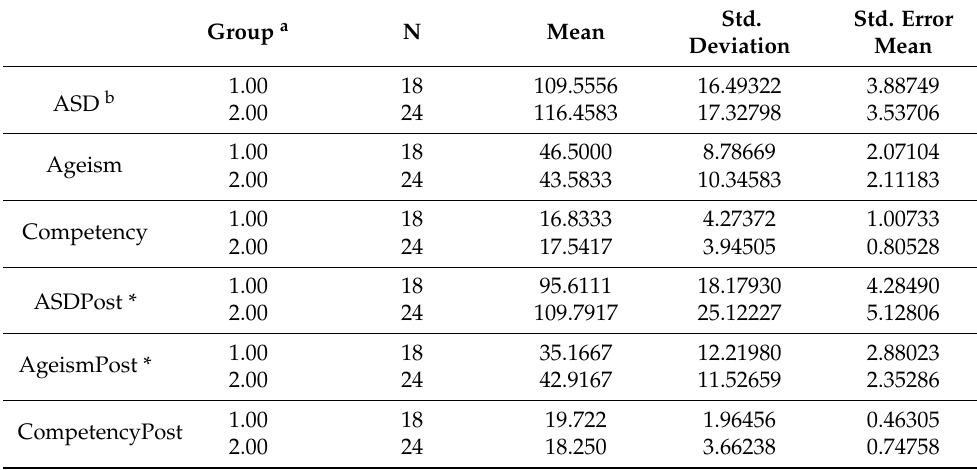
Table 1. Pre-Post Student Assessment Results.